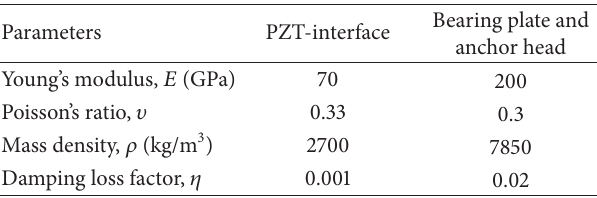
Table 1: Material properties of cable-anchorage